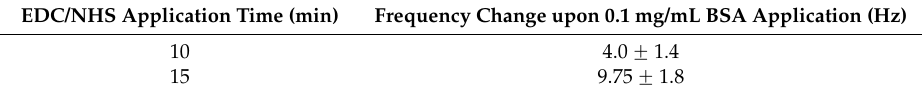
Table 1. Effect of different durations of EDC/NHS activation on non-specific protein binding to the MUA coated QCM